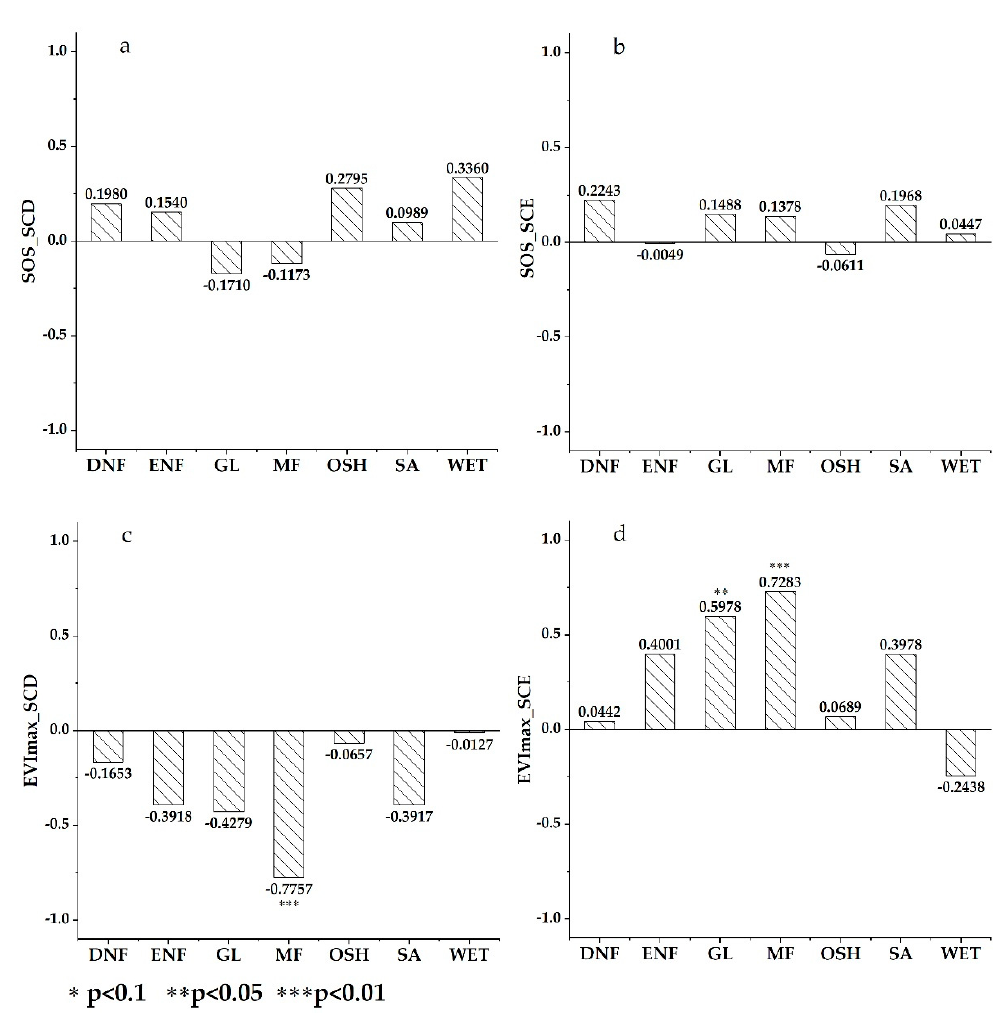
Figure 6. Partial correlation coe ffi cient between ( a ) the start of growing season (SOS) and snow cover duration (SCD); ( b ) start of growing season (SOS) and snow cover end date (SCE); ( c ) annual maximum enhanced vegetation index (EVI max ) and snow cover duration (SCD); ( d ) annual maximum enhanced vegetation index (EVI max ) and snow cover end date (SCE) in di ff erent vegetation types. DNF represents deciduous needleleaf forest; ENF represents evergreen needleleaf forest; GL represents grasslands; MF represents mixed forest; OSH represents open shrublands; SA represents savannas; WET represents permanent wetlands.